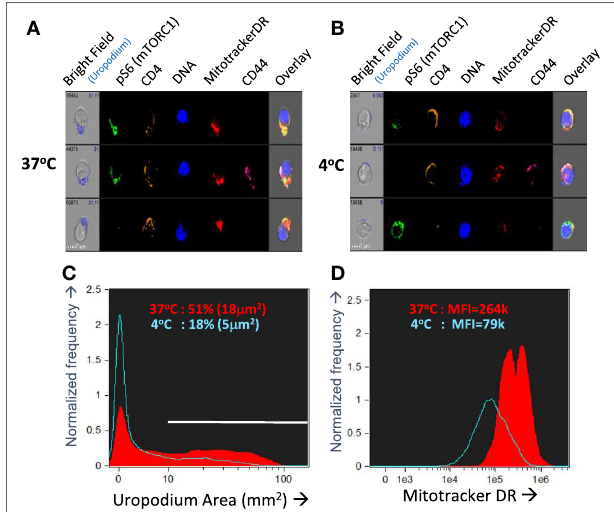
FigUre 3 | Optimizing fixation and staining methodology. (a–D) CTV-labeled naïve female A1RAG CD4 + T cells were stimulated with bone marrow-derived dendritic cells + 100 nM Dby peptide with IL2, TGF β , and ATRA. Staining and fixation was performed in two different ways: either in “ in situ ” method at 37°C was used [ (a) and red filled lines in (c,D) ] or cells were conventionally harvested, spun down, and labeled in PBS + 1% BSA with fixing and permeabilization all at 4°C [ (b) and blue lines in (c,D) ]. Cells were gated and uropodia area determined as described in Section “Materials and Methods.” One of two similar experiments is